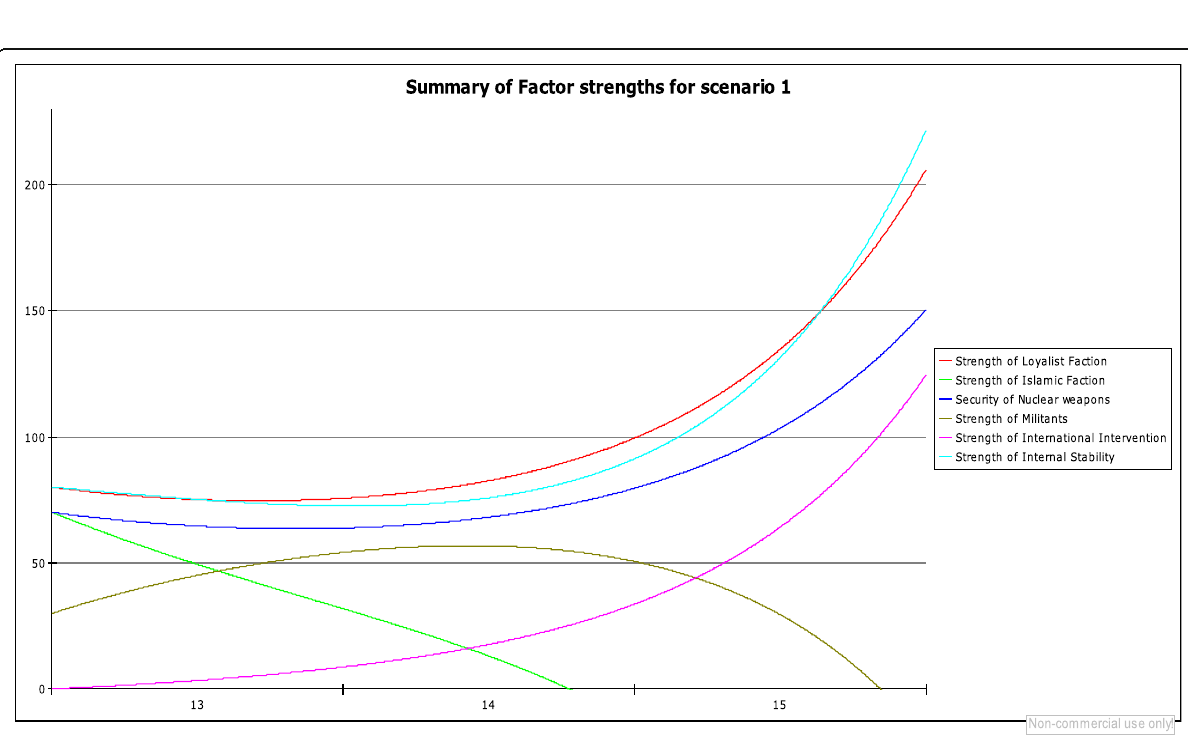
Fig. 3 Example output of a standard stock and flow simulation showing the sensitivity of an international intervention